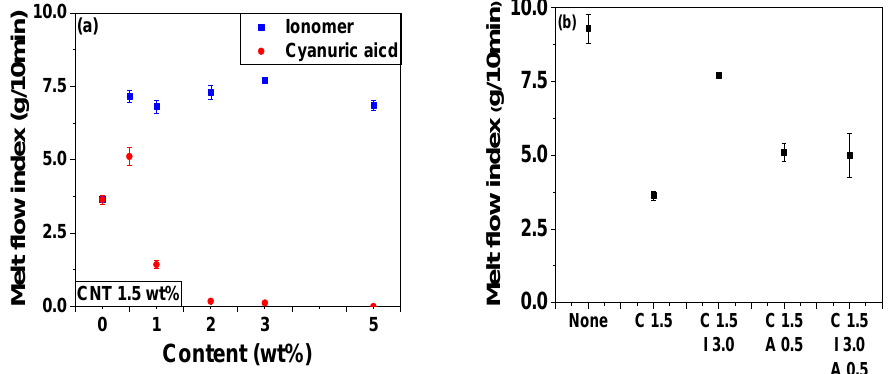
Figure 13. MFI of POM, POM/C1.5, POM/C1.5/I, POM/C1.5/A, and POM/C1.5/I/A nanocomposites with different additive concentrations: ( a ) POM/C1.5; POM/C1.5/I; POM/C1.5/A; ( b ) pristine POM and POM/C1.5/I/A.